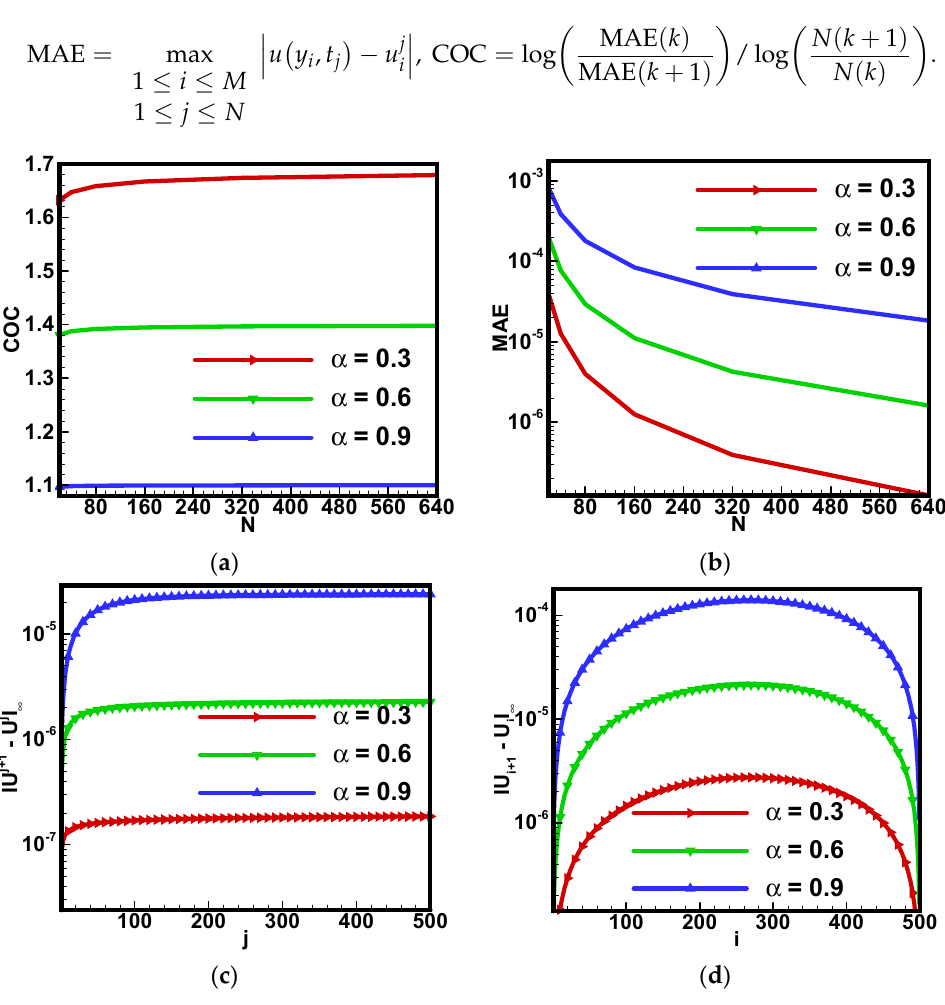
Figure 2. Code validation of proposed scheme and varying time mesh size against ( a ) computational order of convergence (COC) ( b ) maximum absolute error (MAE), and varying mesh size for ( c ) time and ( d ) space against L ∞ -norm between consecutive